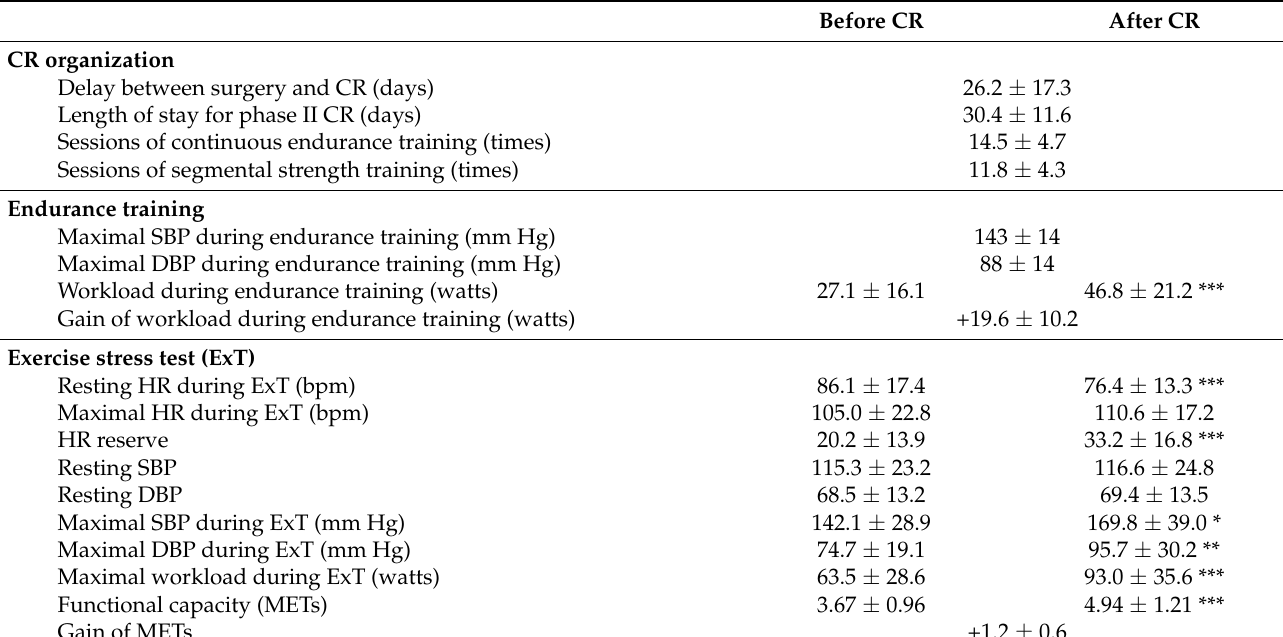
Table 2. Results of training in CR.